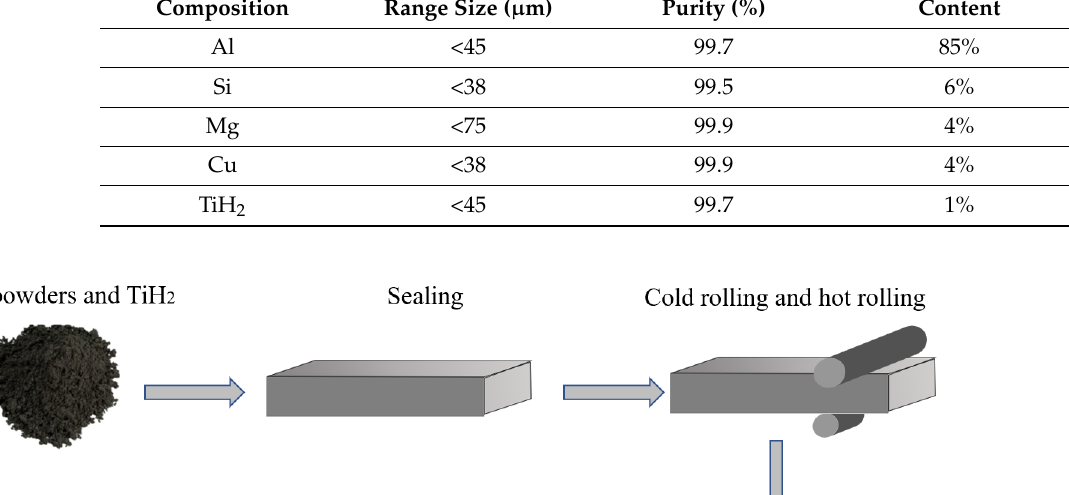
Table 1. Elemental composition of mixed powders [26].